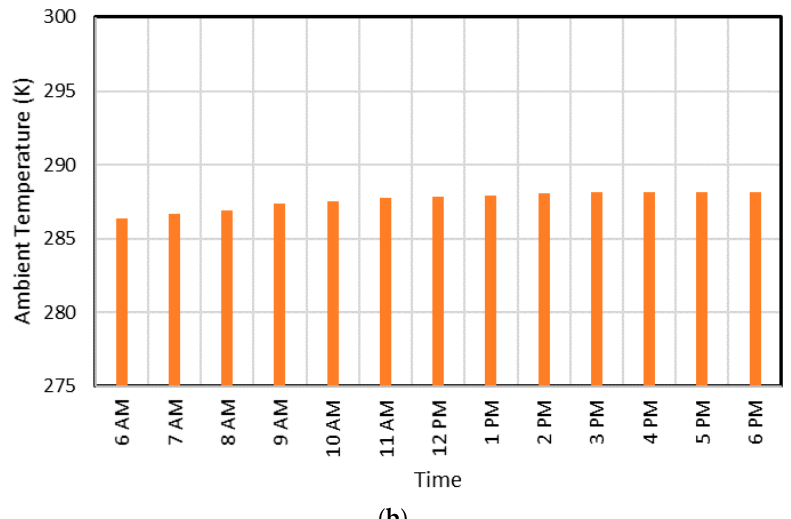
Figure A1. ( a ) Solar irradiance and ( b ) ambient temperature.